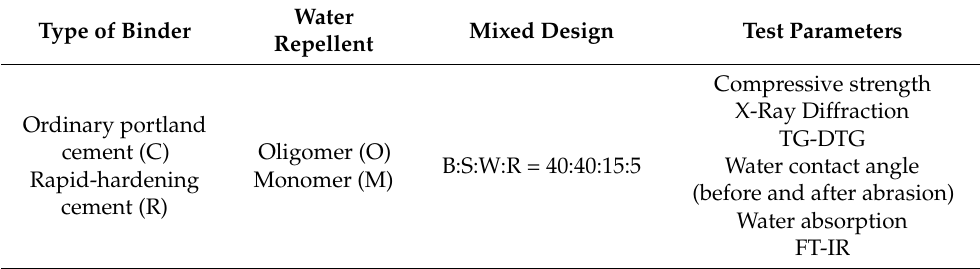
Table 3. Experimental